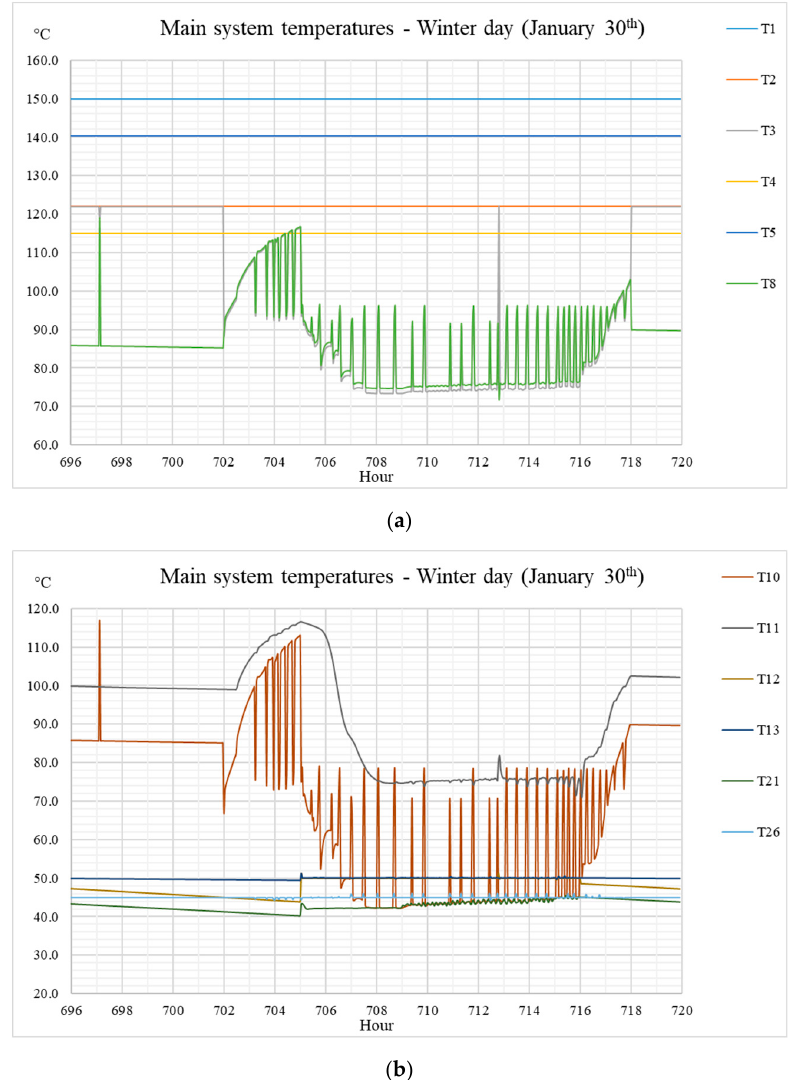
Figure 6. Main system temperatures: winter day (30 January). from T 1 to T 8 ( a ); from T 10 to T 26 (b)